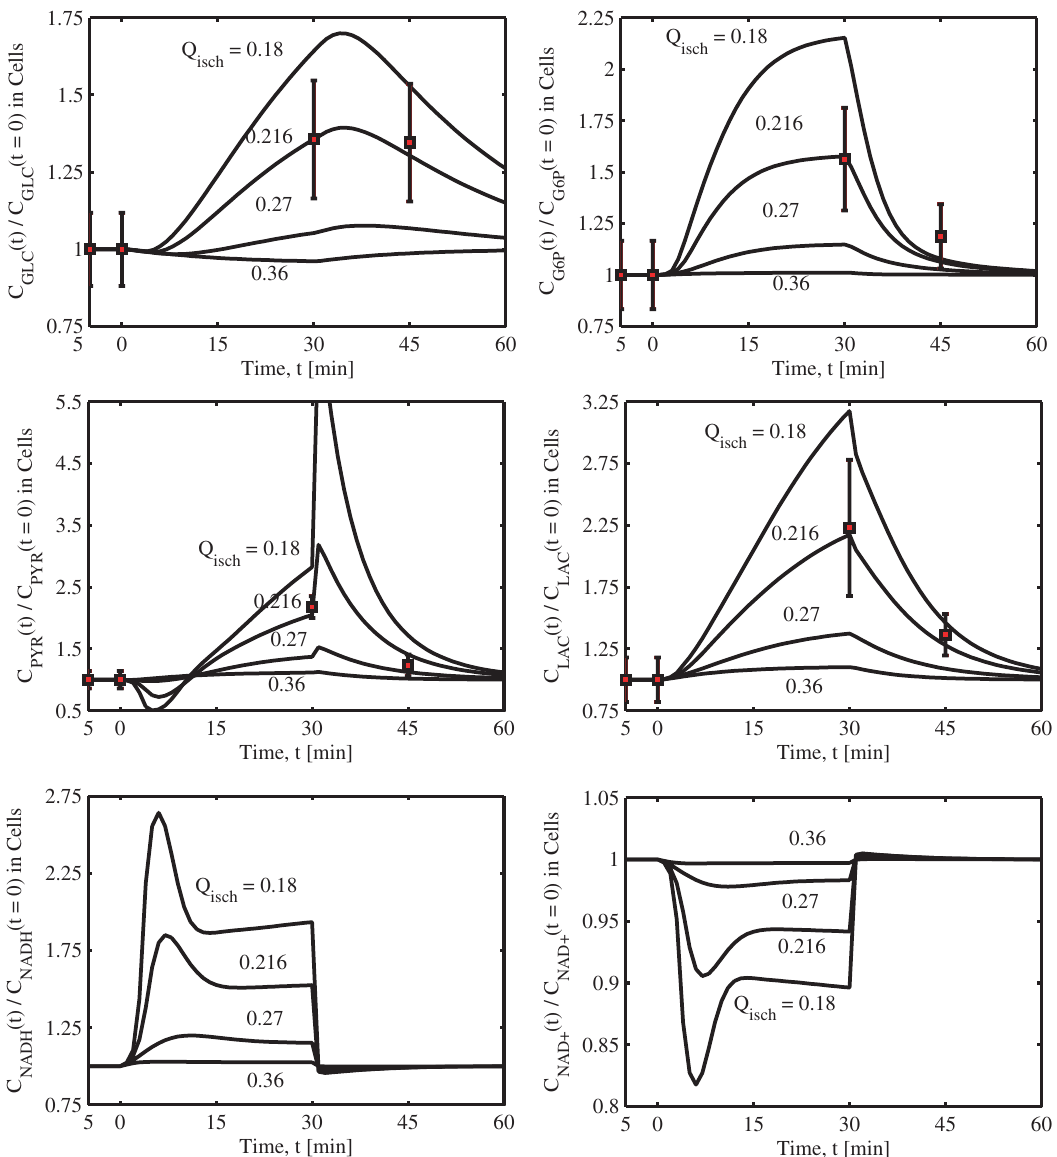
Figure 3. Model-predicted dynamic responses of glycolytic metabolite concentrations and redox states in the muscle tissue cells during the resting, ischemia and recovery periods with varying levels of blood flow reduction and their comparison to the experimental data of Katz [ 22 ] . The responses were computed using the estimated optimal parameter values with the ischemia protocol of 2 5 to 0 min of resting, 0 to 30 min of ischemia, and 30 to 60 min of recovery. The muscle blood flow Q is reduced as a step from 0.9 L/min at rest to Q isch =0.36, 0.27, 0.216, 0.18 L/min at the onset of ischemia and returned to 0.9 L/min at the onset of recovery. The lines represent the model simulation results with the symbols representing the experimental data points (mean 6 SD) corresponding to Q isch =0.216 L/min ( , 76% blood flow reduction). The metabolites concentrations are shown in normalized form, normalized with respect to the resting metabolites concentrations. The concentrations in the tissue cells are calculated based on the formula: C cl =( V cyt C cyt + V mit C mit )/ V cl